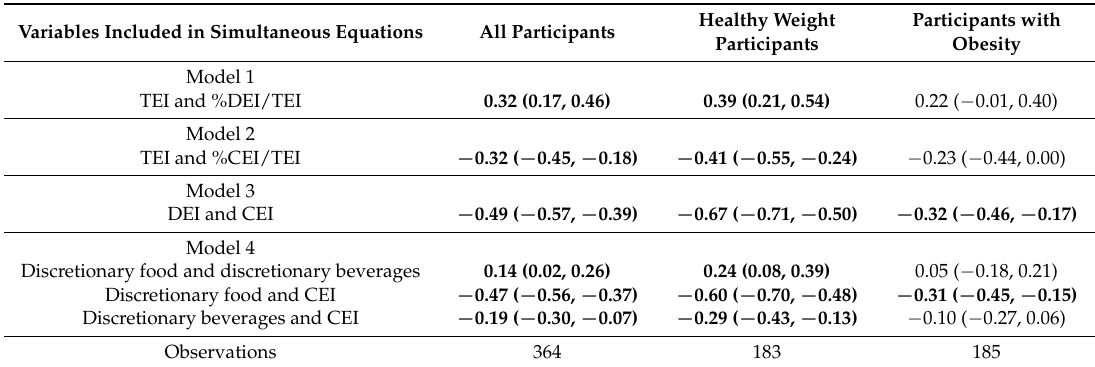
Table 2. Correlations between dietary components in the total sample and by obesity